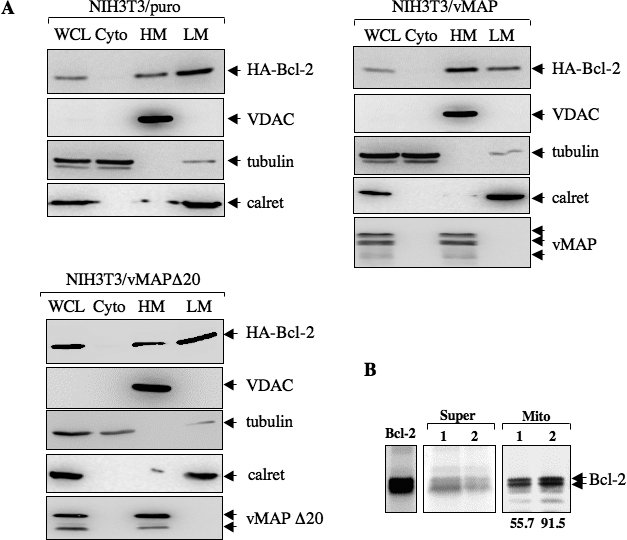
vMAP Enhances the Mitochondrial Localization of Bcl-2(A) Bcl-2 intracellular distribution by subcellular fractionation. NIH3T3/puro, NIH3T3/vMAP, and NIH3T3/vMAPΔ20 cells were transfected with HA-Bcl-2 expression vector. Twenty μg of WCL, cytosolic (Cyto), heavy membrane (HM), and light membrane (LM) fractions were analyzed by immunoblotting with antibodies to HA epitope (HA-Bcl2, top panel), VDAC, tubulin, calreticulin (calret), or vMAP.(B) In vitro Bcl-2 mitochondrial association assay. The mitochondrion-enriched HM fractions of NIH3T3/puro (lane 1) or NIH3T3/vMAP cells (lane 2) were mixed with in vitro translated 35S-labeled Bcl-2 at 30 °C for 2 h, centrifuged at 13,000 rpm for 15 min to separate soluble (Super) and insoluble (Mito), followed by autoradiograph. The left panel indicates Bcl-2 translated in rabbit reticulocyte lysates. The numbers below autography indicate the levels (intensity of the Bcl-2 doublet) of mitochondrion-associated Bcl-2 determined by Phosphor Imager analysis.